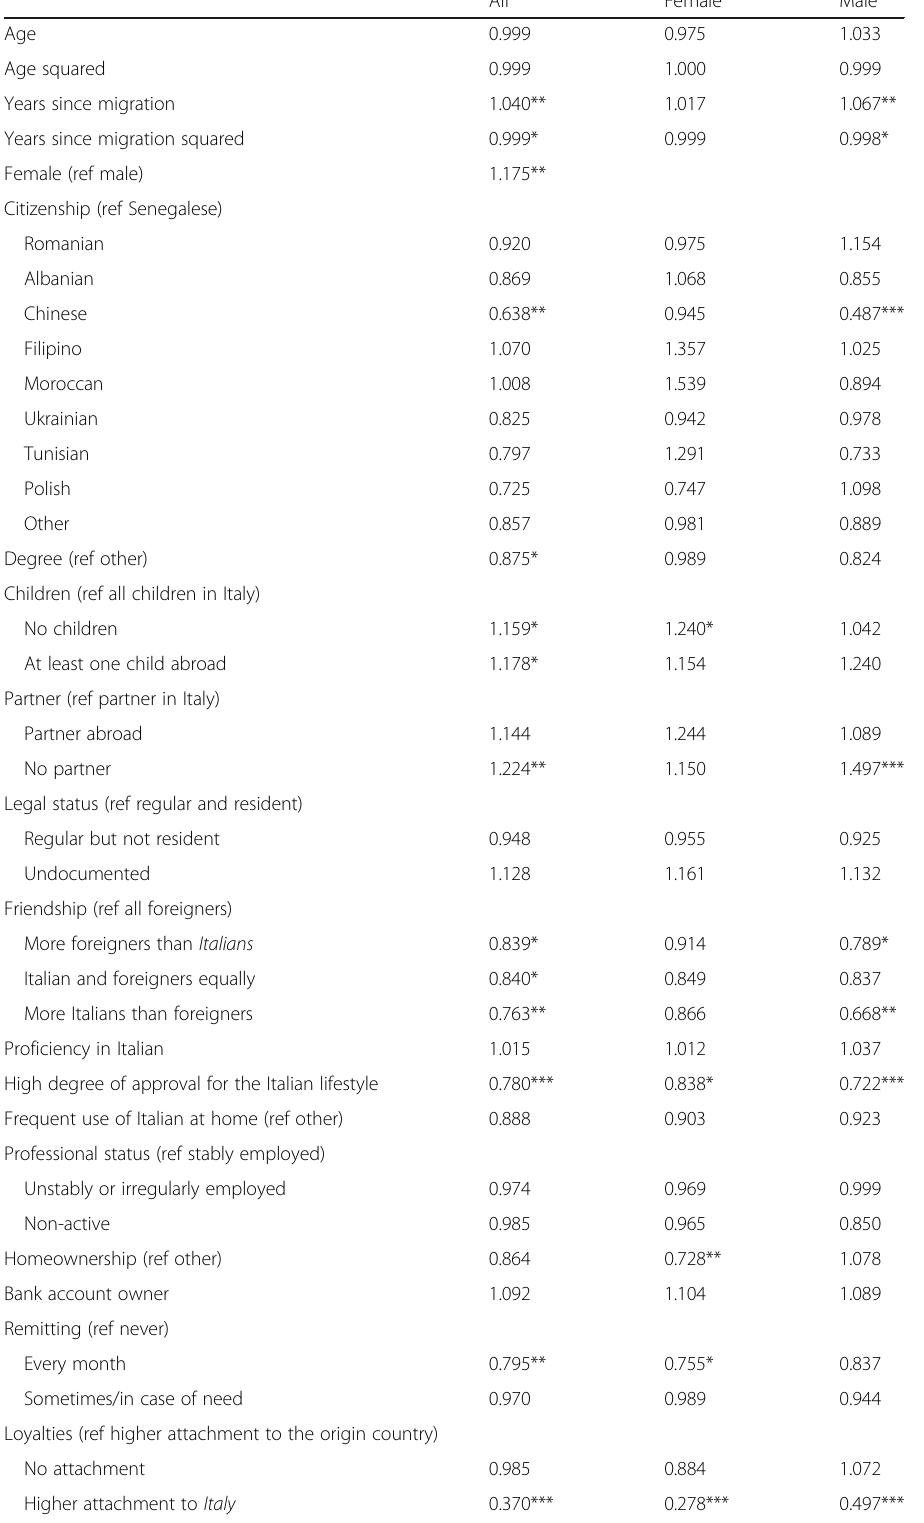
Table 2 Odds ratios and significance from the logistic regression models dependent variable plan for the future (baseline ‘ migrants with future plan ’